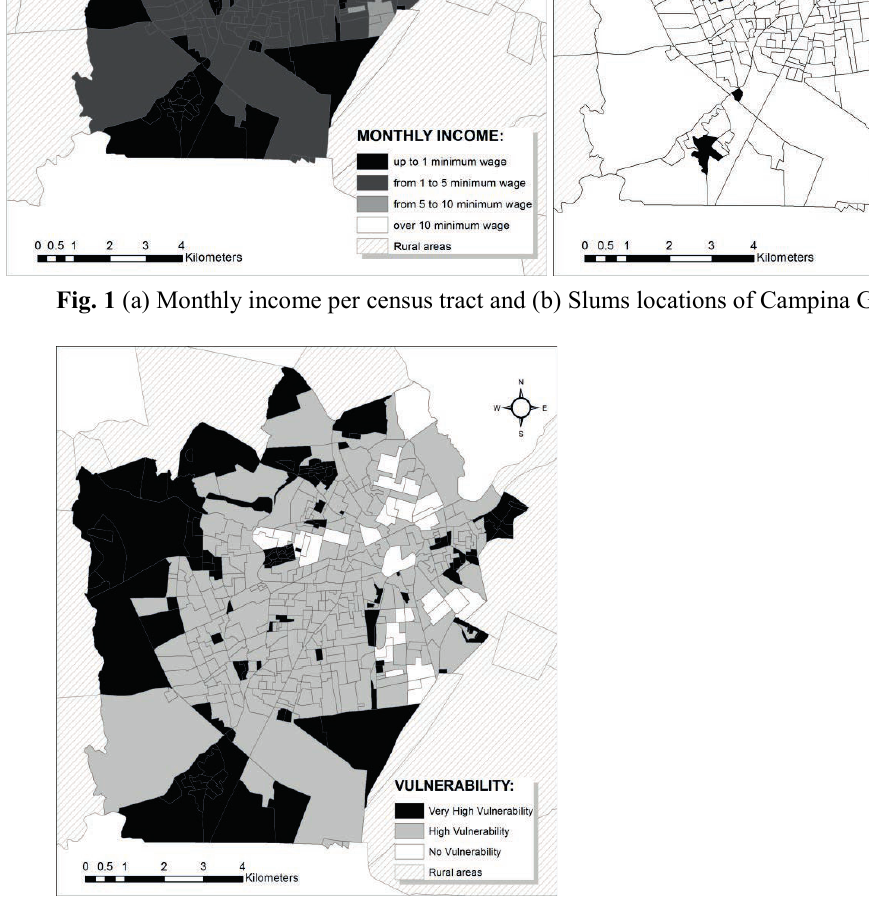
Fig. 2 Vulnerability map based on economic and social criteria